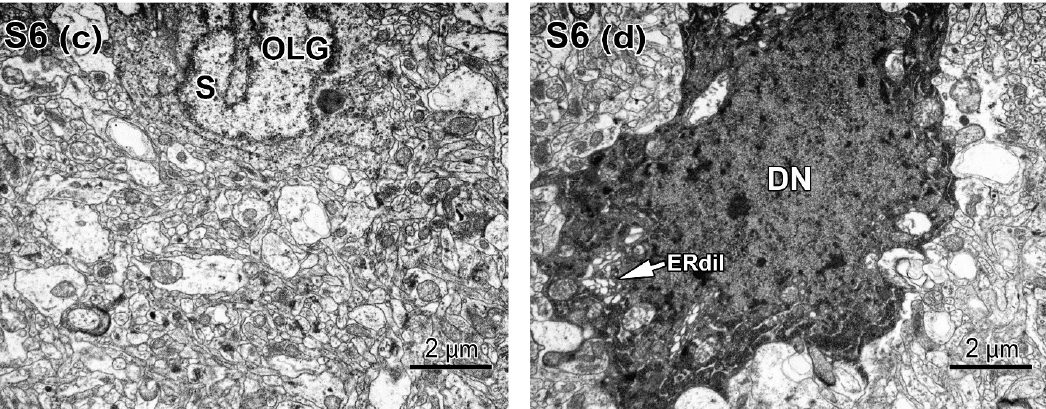
Figure 8. Electron micrographs showing neurons, oligodendrocytes, and vascular changes after 6 days of repetitive exposure to restraint stress; ( a ) Prominent perivascular lysis (PL) between CA3 neurons; ( b ) CA3 neuron with irregular nuclear shape (black arrows), mitochondrial lysis (asterisk), and frequent ribosomes (double arrows); ( c ) Oligonderocyte (OLG) with stromal aspect (S) of the nucleus; ( d ) Dark neuron (DN) with the dilated endoplasmic reticulum (ERdil, white arrow) in the CA3 hippocampal area; Original magnification ×6000.